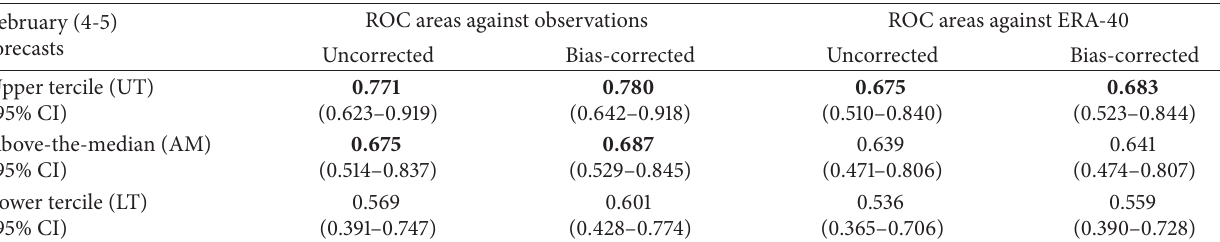
Table 2: ROC areas for February (4-5) forecasts by DEMETER-3 validated against observations and ERA-40 data over northern